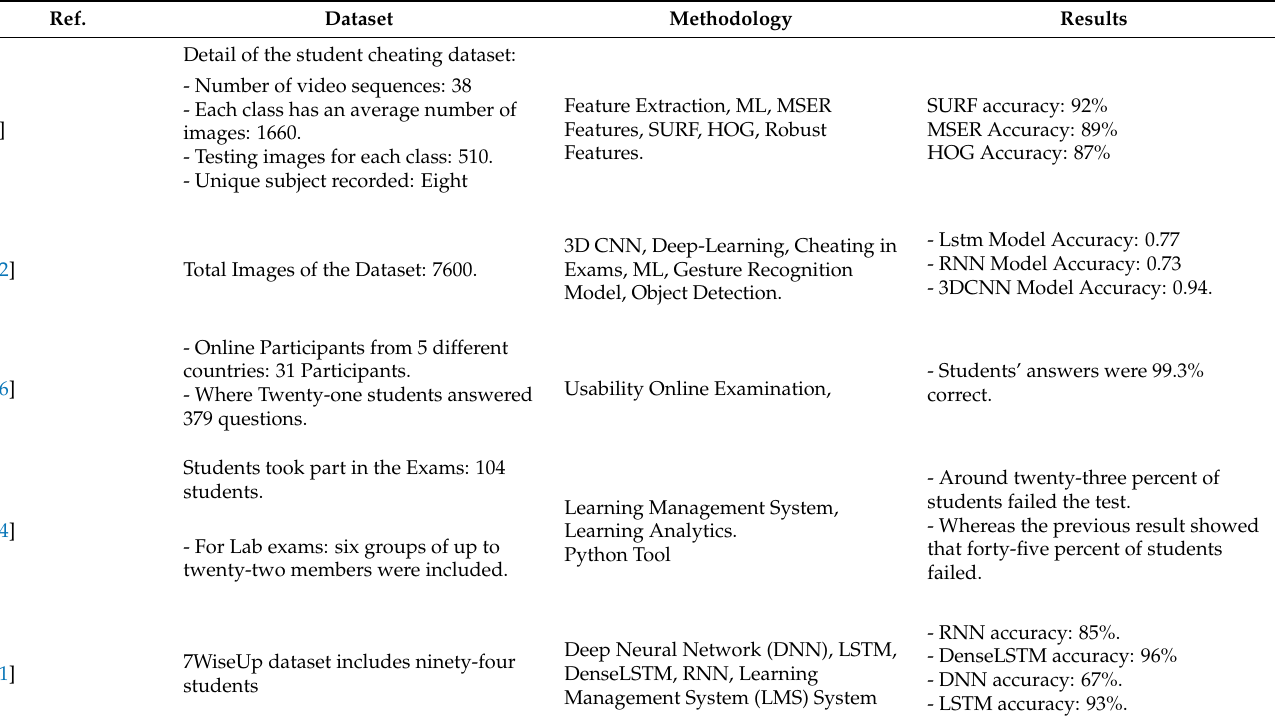
Table 1. List of Past References, including methodology, dataset, techniques, and results.